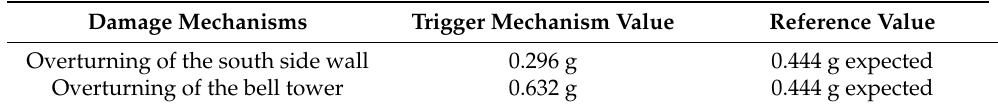
Table 6. Damage mechanisms calculated according to analytical